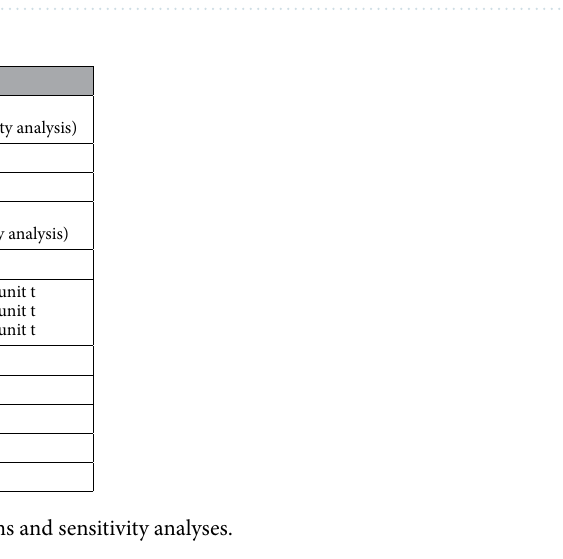
Table 1. Breakdown of total transmission rate and recovery rate of the conventional SIR model, Model A and Model B.